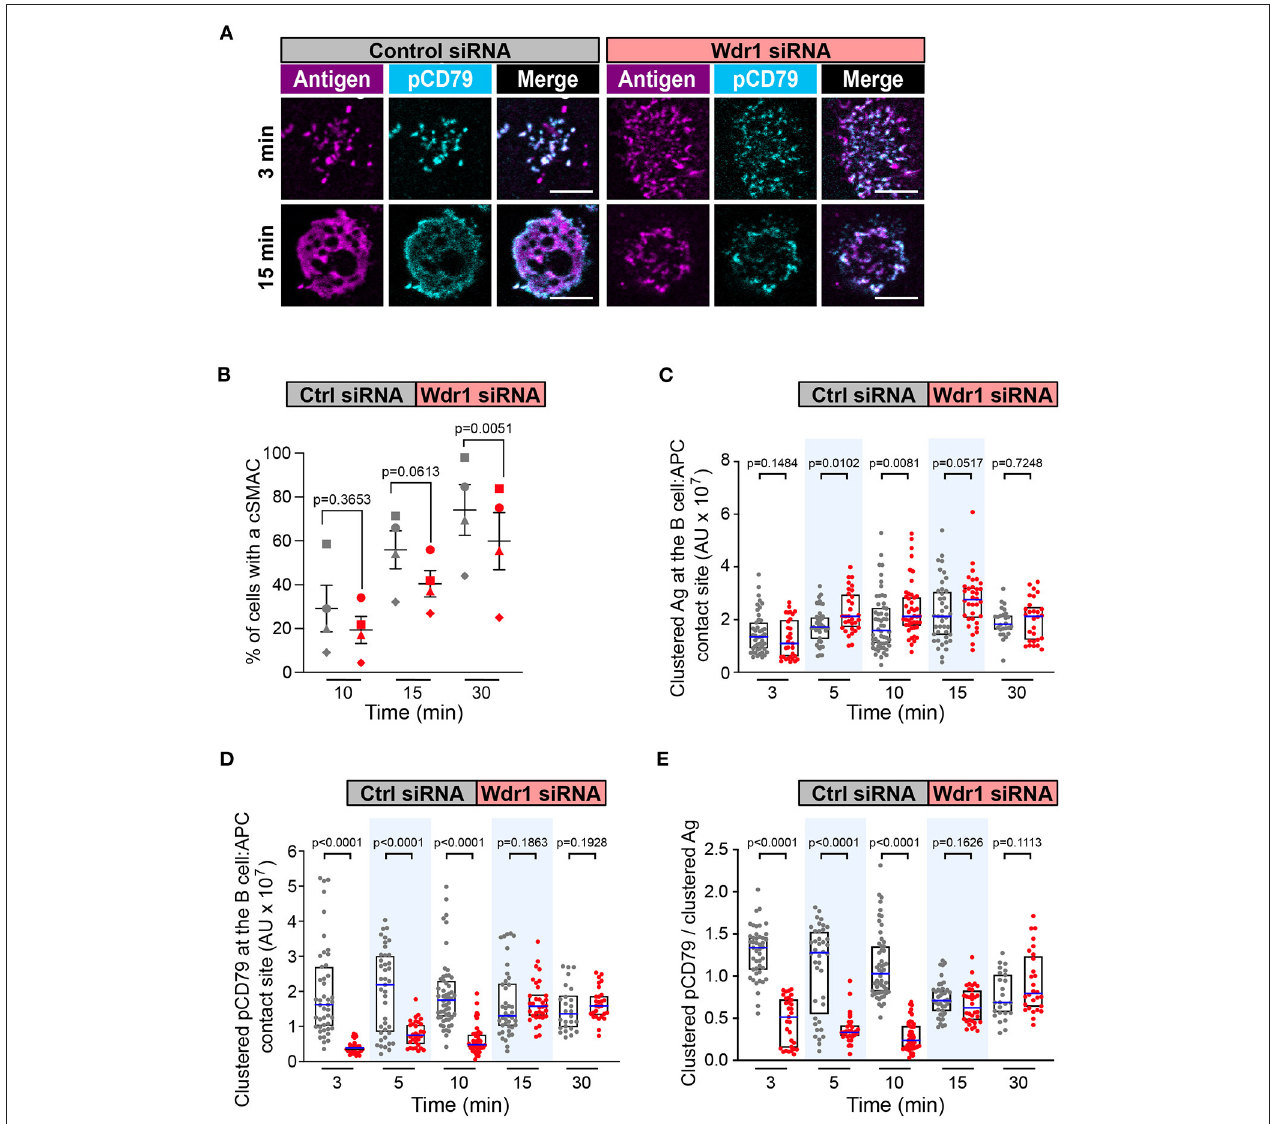
FIGURE 5 | Wdr1 is important for cSMAC formation and BCR signaling at the immune synapse. A20 D1.3 B cells that had been transfected with control (Ctrl) siRNA or Wdr1 siRNA were added to mHEL-HaloTag-expressing COS-7 APCs. The cells were then fixed at the indicated times and the B cell-APC interface was imaged by spinning disk microscopy. (A) Representative images. Scale bars: 5 µ m. (B) For each time point, the percent of cells that had formed a cSMAC, defined as > 90% of the total Ag fluorescence intensity being contained in 1-2 clusters, is graphed. Each symbol on the graph represents an independent experiment. Paired t -tests were used to calculate p-values. (C,D) The total fluorescence intensity of the mHEL-HaloTag Ag (C) or pCD79 (D) that was present in clusters at the B cell-APC contact site was quantified for each cell. Each dot is one cell. n > 25 cells per condition. The median (blue line) and interquartile ranges (black box) are shown. (E) For each B cell represented in (C,D) , the total fluorescence intensity of clustered pCD79 was divided by the total fluorescence intensity of clustered Ag. The ratio is graphed. The median (blue line) and interquartile ranges (black box) are shown. The data in (C–E) are from the same experiment, which is representative of four independent experiments. The Mann-Whitney U test was used to calculate p-values for (C–E)